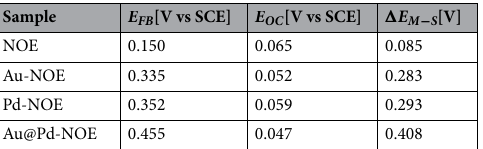
Table 1. Values of flat band potential, open circuit potential and energy barrier for bare and decorated samples.